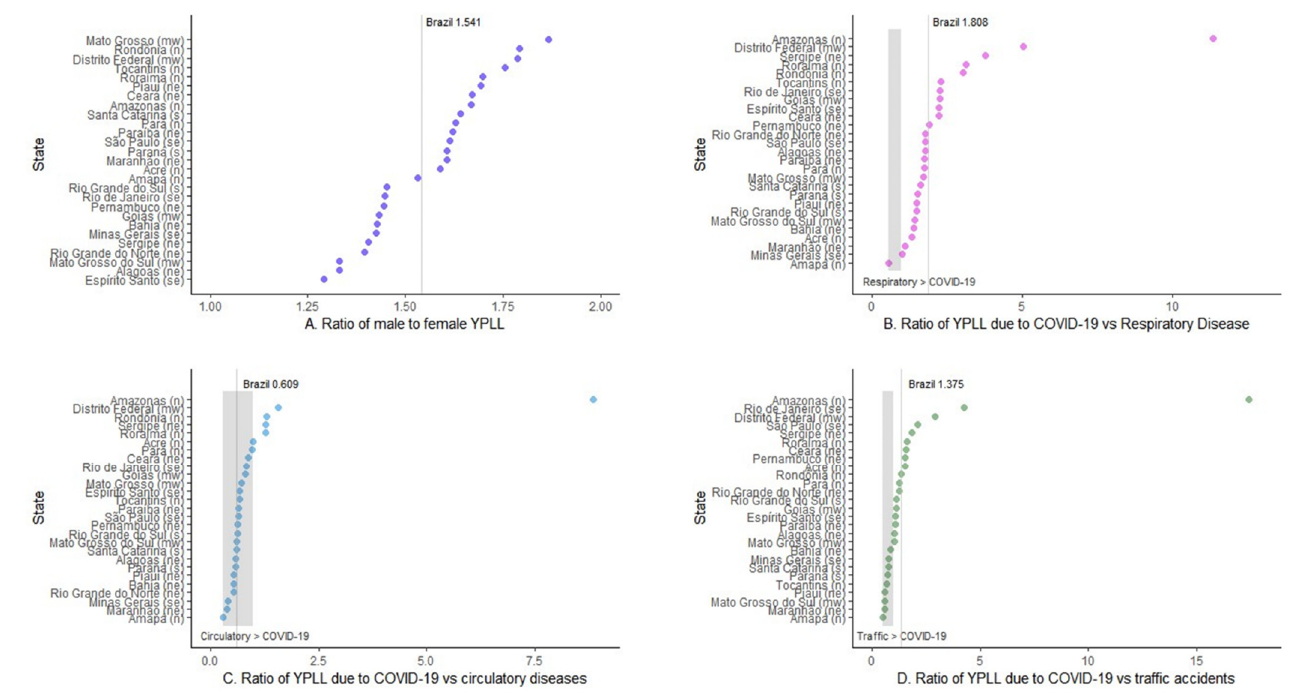
Figure 4. Years of potential life lost (YPLL) ratio in Brazil (2020) by sex ( A ), other respiratory diseases ( B ), heart disease ( C ) and land traffic accidents ( D ). When mortality, by sex or other causes, affects the YPLL equally, the ratio is 1. In charts B – D , values above 1 mean that the YPLL for COVID-19 was higher than for the other causes, the opposite is true for values less than 1. The Brazil-wide ratio is represented by the vertical line on each chart. The names of the states followed by the letters (in parentheses) represent the region of the country in which they are located (n = north, ne = north-east, mw = mid-west, se = south-east and s = south).